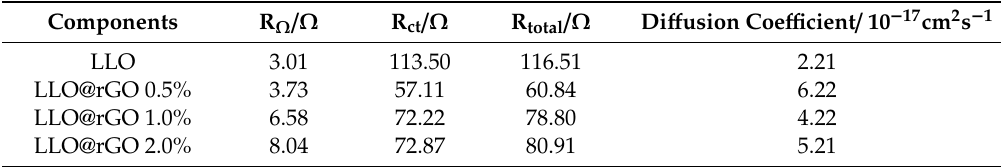
Table 1. The fitting values of the components in the simplified equivalent circuit.